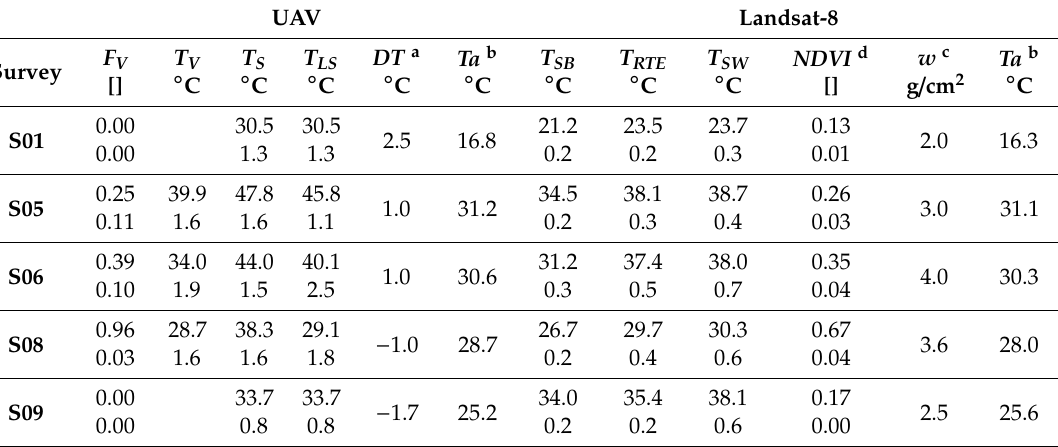
Table 1. Temperature statistics over tiles derived from UAV and Landsat-8 using single band method uncorrected for atmospheric e ff ects (SB), radiative transfer equation (RTE), and split window method (SW). Statistical results of thermal surveys of the study area. Average (up row) and standard deviation (low) over 12